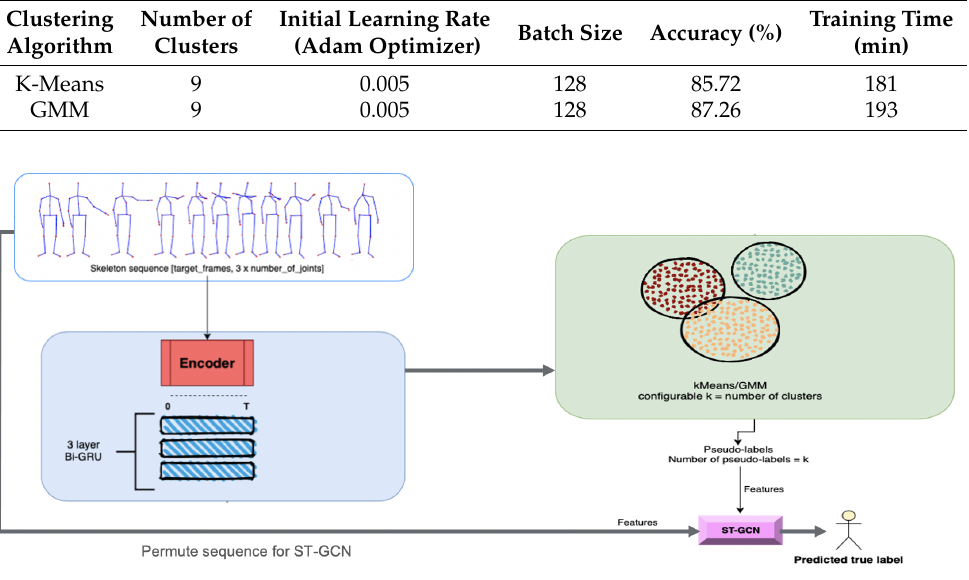
Table 4. Results of the 1-Classifier Approach.